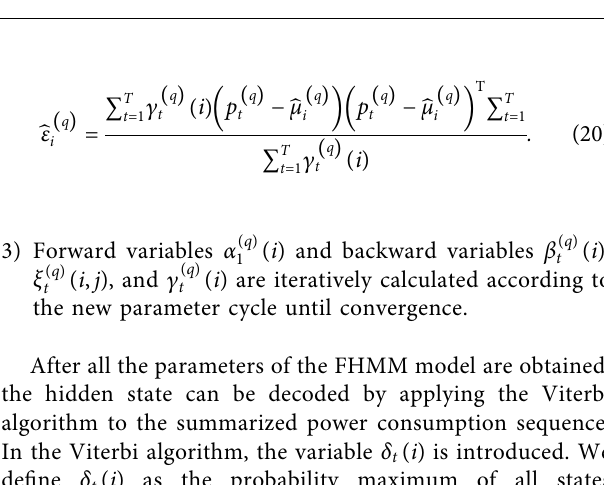
FIGURE 5 | Framework of nonintrusive monitoring for the EV